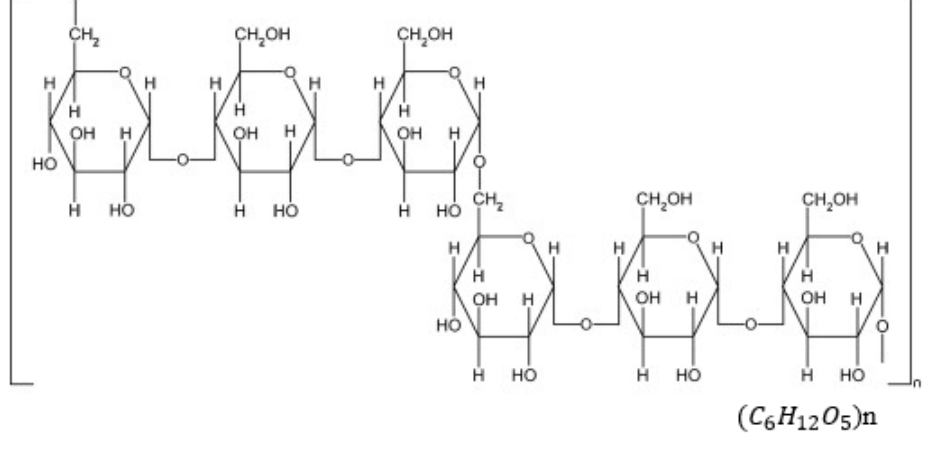
Figure 1. Chemical structure of